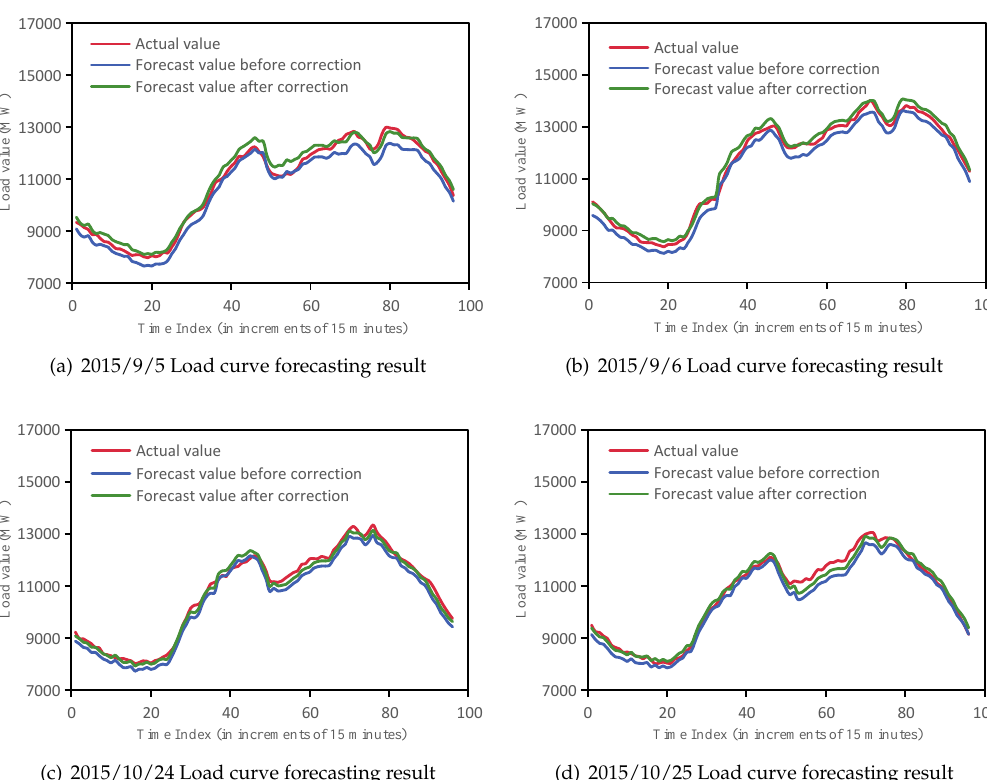
Figure 3. Forecasting curves compared with the actual load curve in 2015